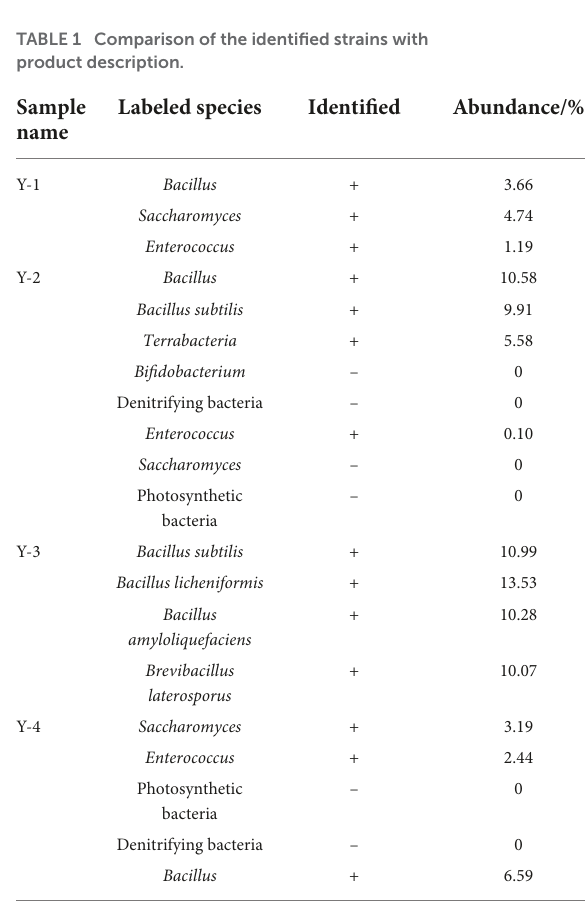
TABLE 1 Comparison of the identified strains with product